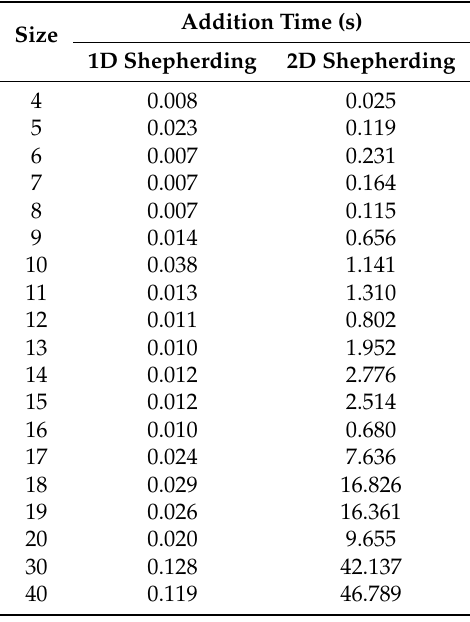
Table 1. Average Time of Addition of Stabilization for Shepherding